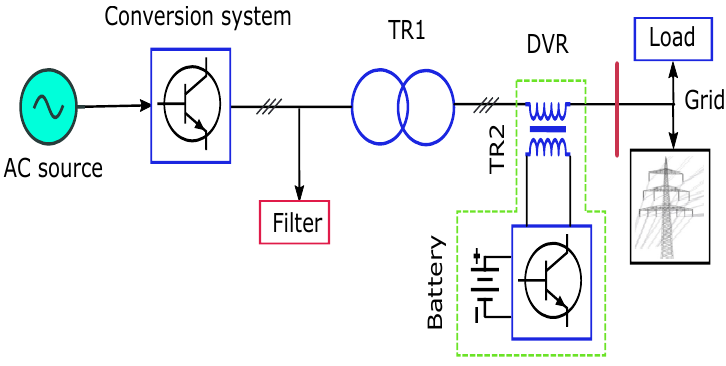
Figure 1. Dynamic voltage restorer–integrated AC grid system to mitigate voltage